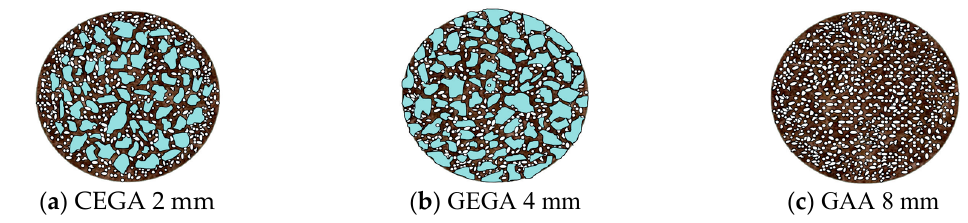
Figure 8 . The lightweight grain structure and porosity distribution for: ( a ) 2 mm GEGA, ( b ) 4 mm GEGA, and ( c ) 8 mm GAA.